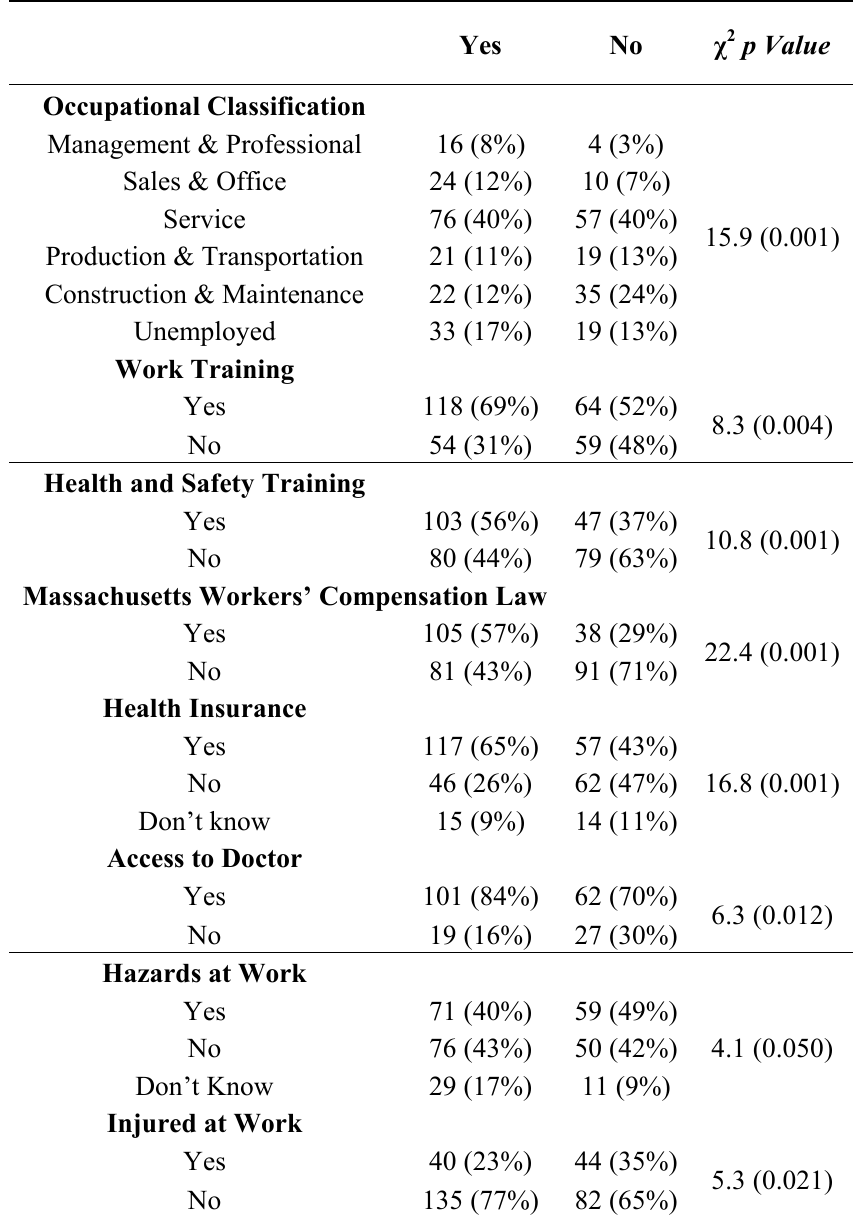
Table 3. English proficiency and occupation and health outcomes obtained from self-identified immigrant workers, Somerville, Massachusetts